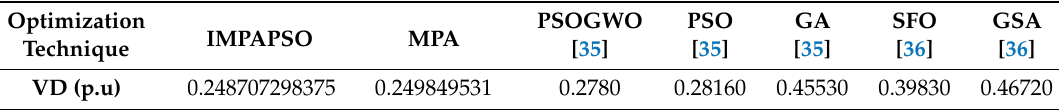
Table 3. IEEE 30-bus system’s second case objective